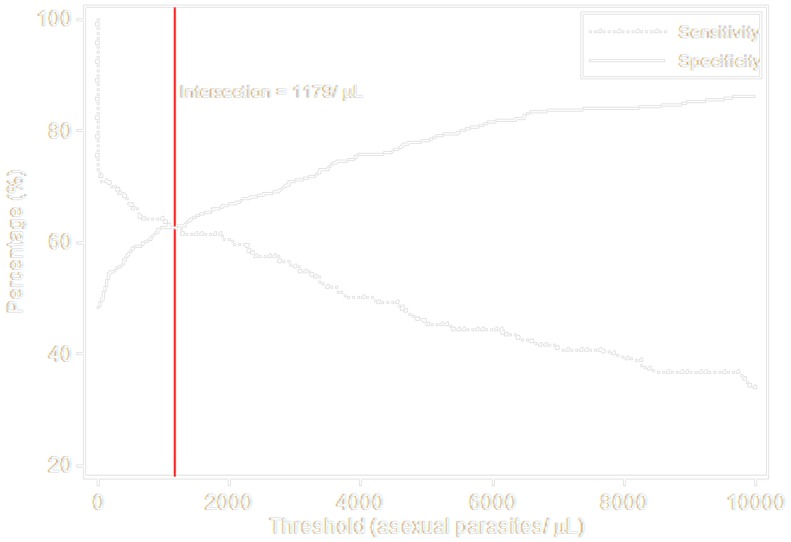
Malaria case definition using objective fever (Temperature≥38.0)/History of fever: Sensitivity and specificity of alternatives parasite threshold.